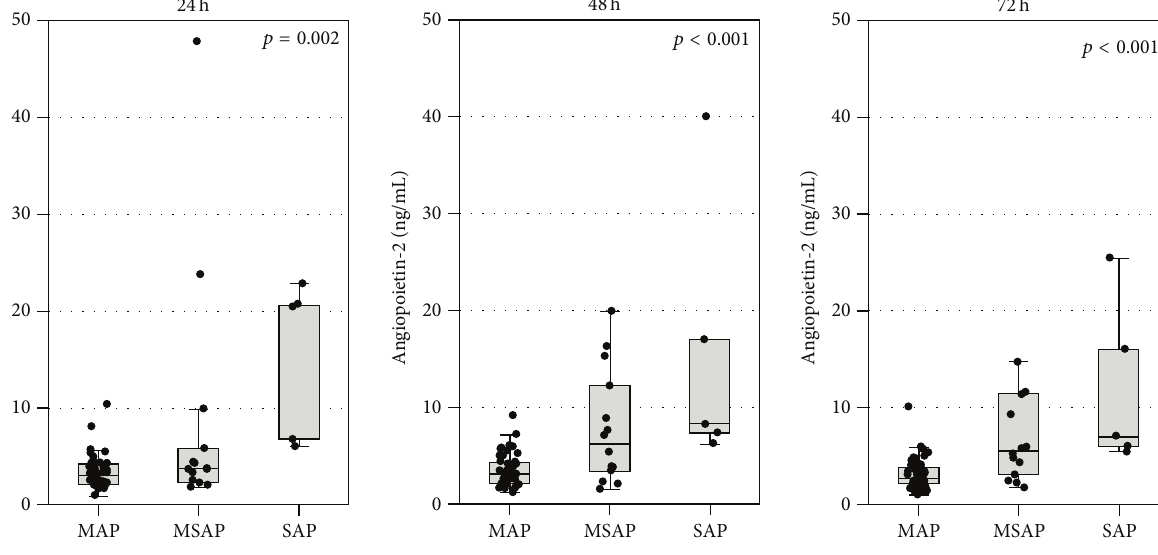
Figure 1: Serum angiopoietin-2 concentrations at 24, 48, and 72 hours after the onset of symptoms in patients with mild (MAP), moderately severe(MSAP),andsevereacutepancreatitis(SAP).Dataareshownasmedian,25th–75thpercentile(boxes),andnonoutlierrange(whiskers); the points represent raw